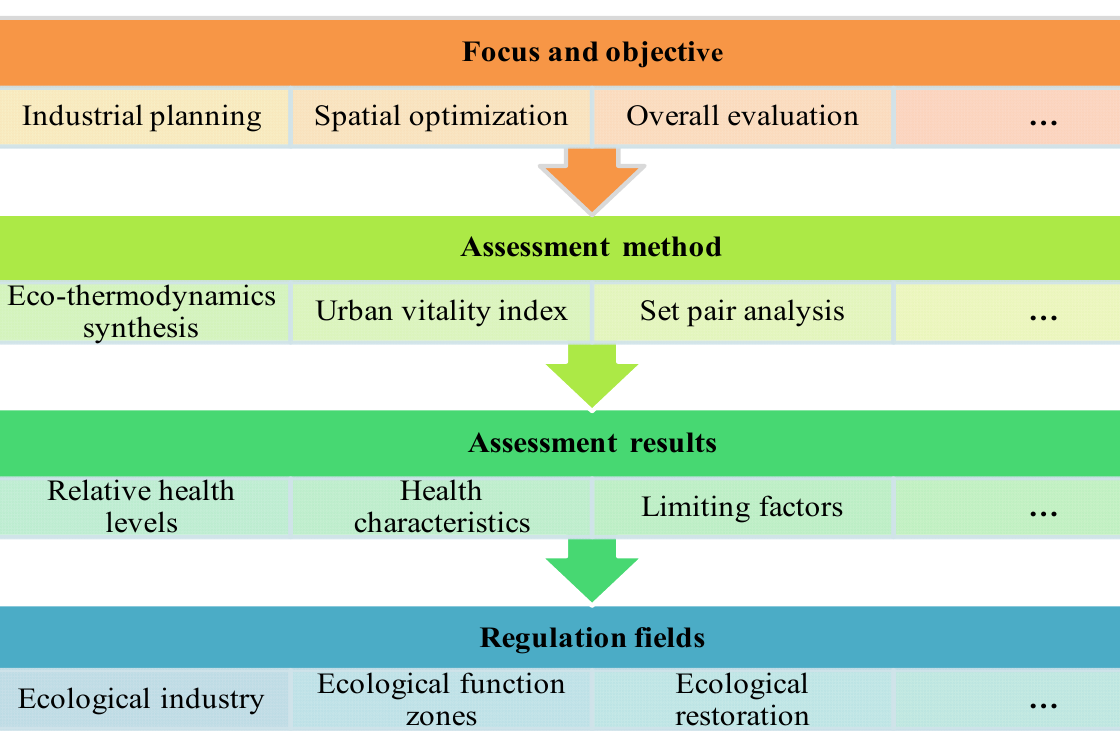
Figure 4. Procedure of urban ecosystem health assessment.